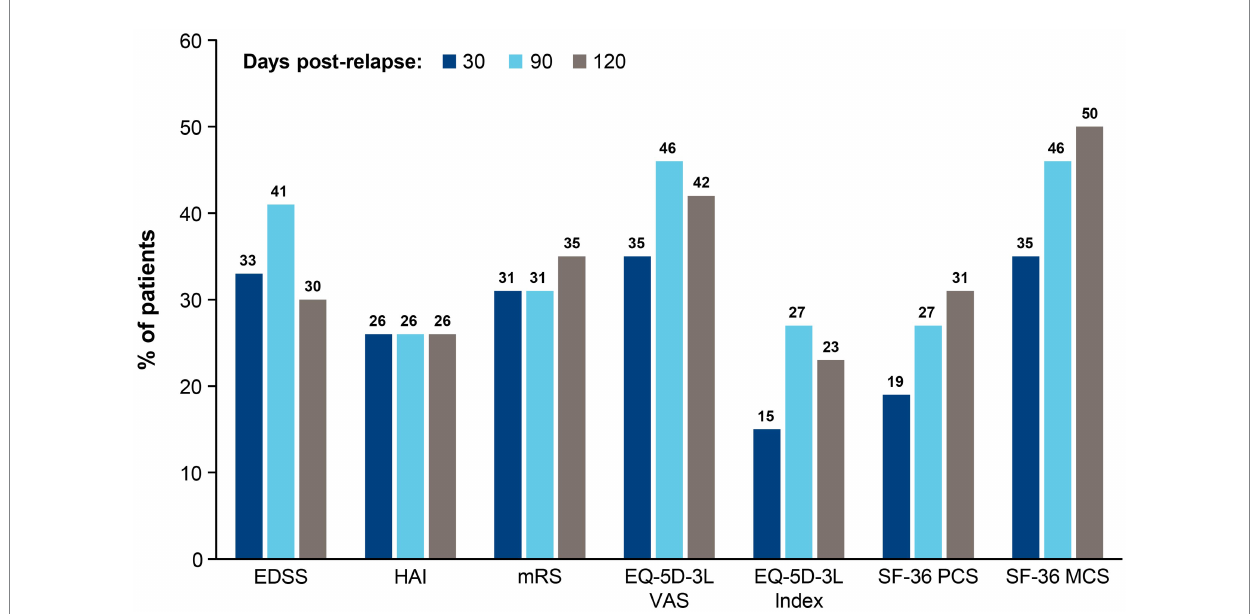
FIGURE 3 Proportion of patients who experienced clinically meaningful worsening a between pre- and post-relapse scores at 30, 90, and 120 days. a Clinically meaningful worsening implies the smallest worsening of symptoms to impact the management care plan of a patient. For each instrument, clinically meaningful worsening was defined as follows: EDSS: ≥ 2.0-point increase if baseline score = 0, ≥ 1.0-point increase if baseline score ≥ 1.0–5.0, ≥ 0.5-point increase if baseline score ≥ 5.5; HAI: ≥ 2.0-point increase if baseline score = 0, ≥ 1.0-point increase if baseline score ≥ 1; mRS: 1.0-point increase; EQ-5D-3L VAS: 8.0-point decrease; EQ-5D-3L Index: 0.18-point decrease; SF-36 PCS: 5.0-point decrease; SF-36 MCS: 5.0-point decrease. EDSS, Expanded Disability Status Scale; EQ-5D-3L, European Quality of Life 5-Dimension questionnaire 3-Level; HAI, Hauser Ambulation Index; MCS, mental component summary; mRS, modified Rankin scale; PCS, physical component summary; SF-36, 36-Item Short-Form Health Survey; VAS, visual analogue